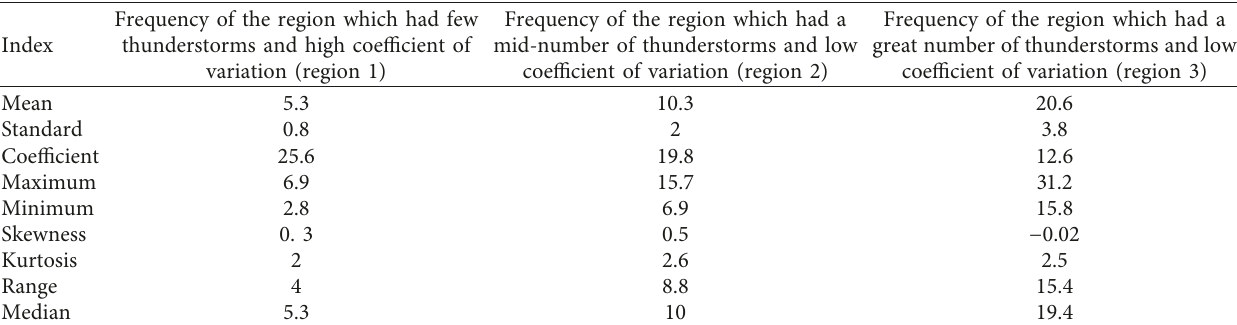
Table 6: Descriptive statistics for regions influenced by Iran’s thunderstorms based on cluster